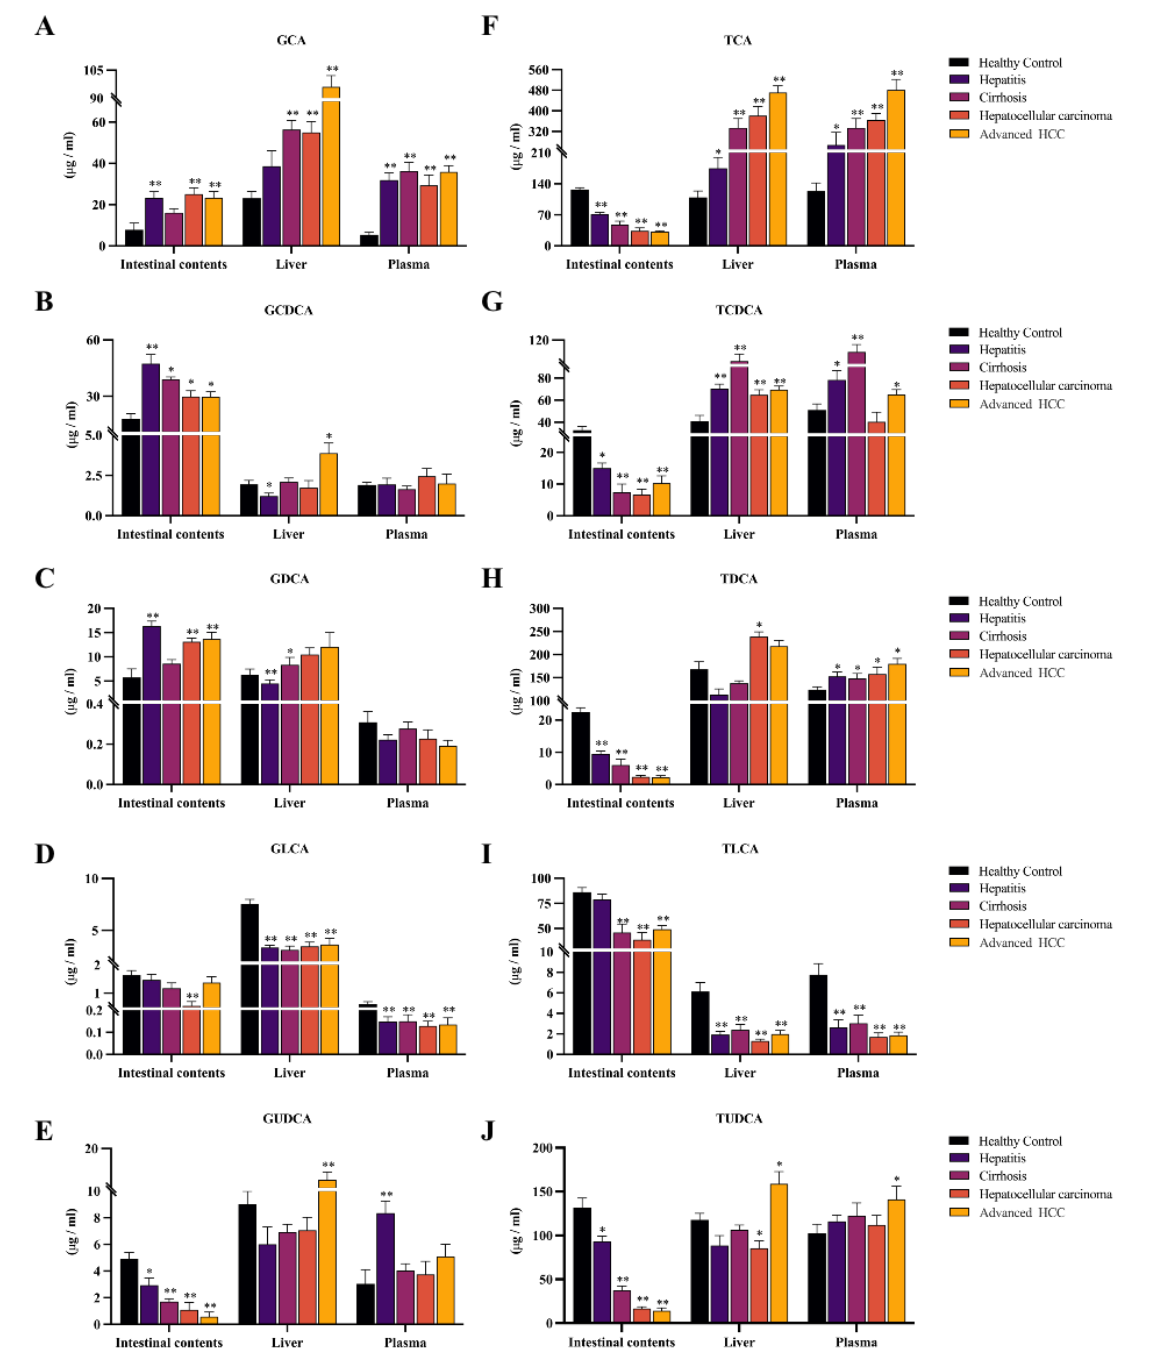
Figure 4. The changes of conjugated BAs in the plasma and liver of DEN-induced model rats were approximately the same as those of prototype BAs. However, the trend in intestinal contents was the opposite, where all taurine-conjugated BAs were significantly reduced. ( A – E ): Distribution of glycio- conjugated BAs in three samples. ( F – J ): Distribution of taurine-conjugated BAs in three samples. The figure indicates statistical significance compared with healthy controls by t -tests, * p < 0.05, ** p < 0.01. Next, the association between discrepancies in bile acid levels and inflammatory- cancer transformation was established by two multivariate modeling approaches, PCA and OPLS-DA. The results showed that they were distinguished by respective disease